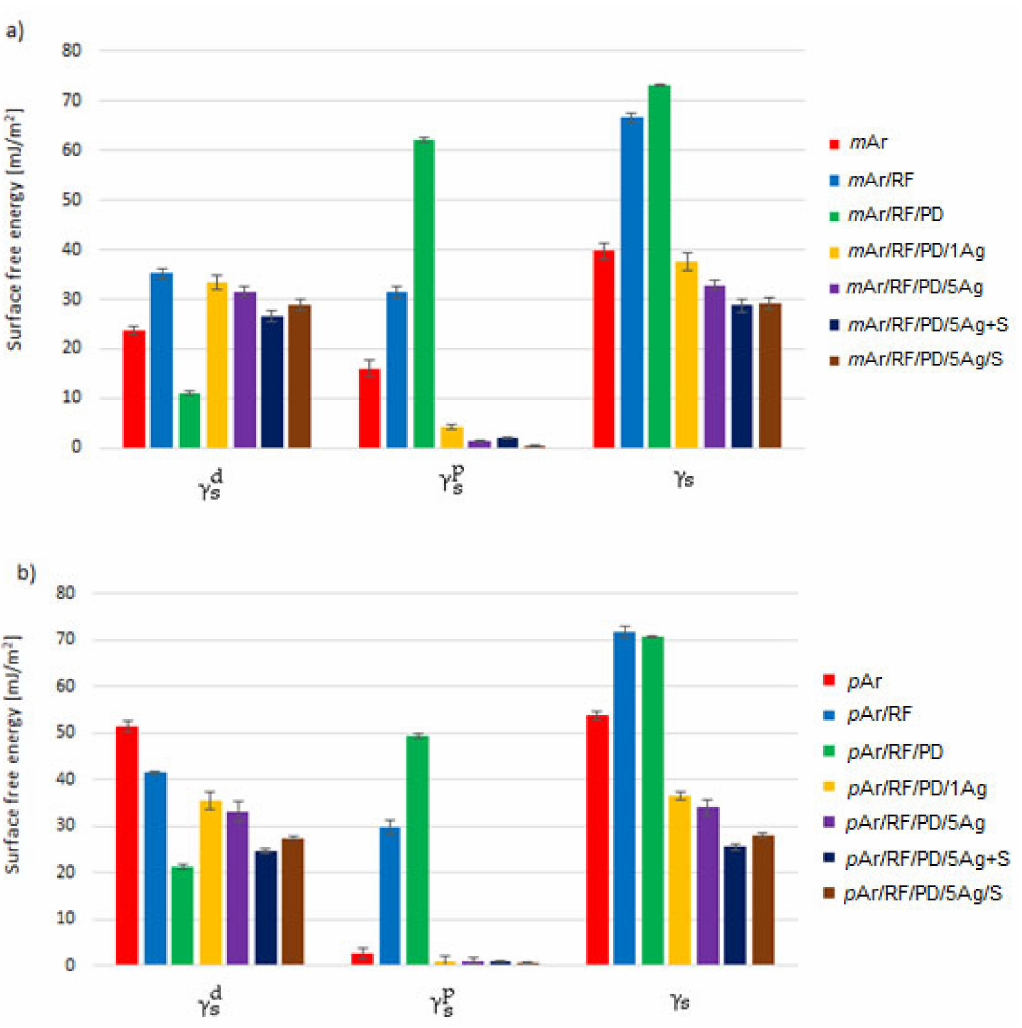
Figure 9. Surface free energy ( γ s ) of unmodified and modified m Ar ( a ) and p Ar ( b ) fabrics ( γ sd —dispersive component, γ sp —polar